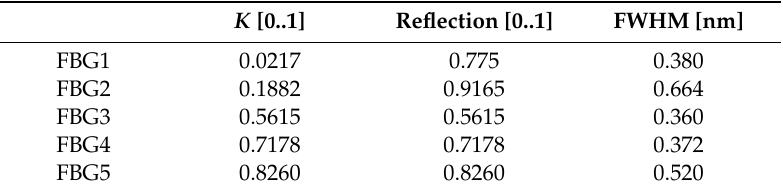
Table 2. Parameters of fiber Bragg gratings fabricated for